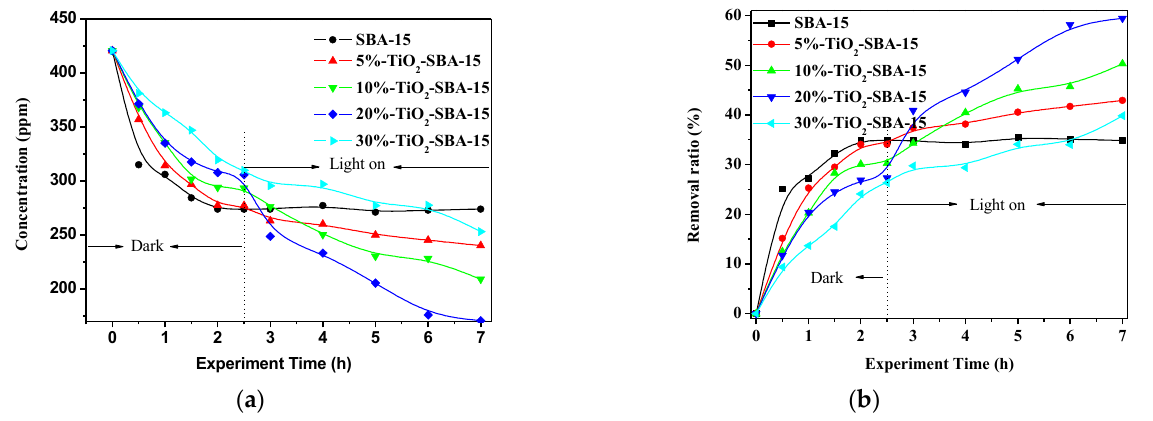
Figure 8. The photocatalytic performance curve of different TiO 2 loading catalysts degrading toluene, ( a ) concentration of toluene for removal process, ( b ) removal ratio of toluene for removal process.